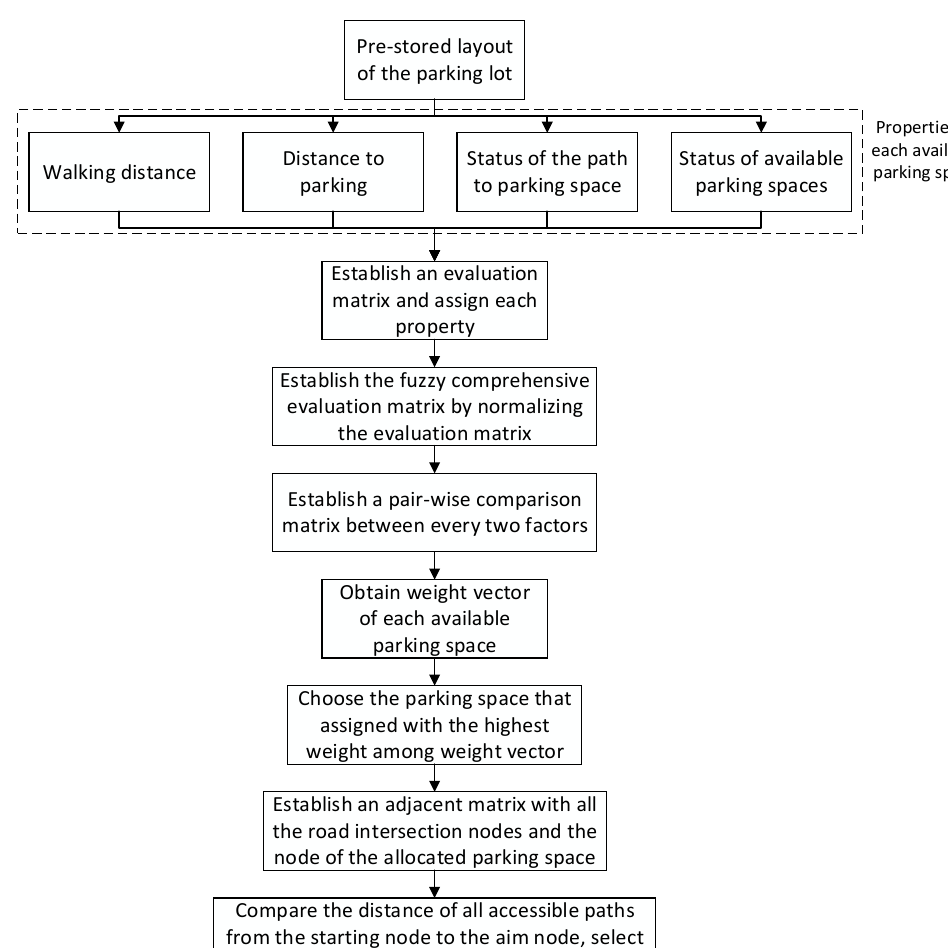
Figure 5. Example of a parking scenario 1.